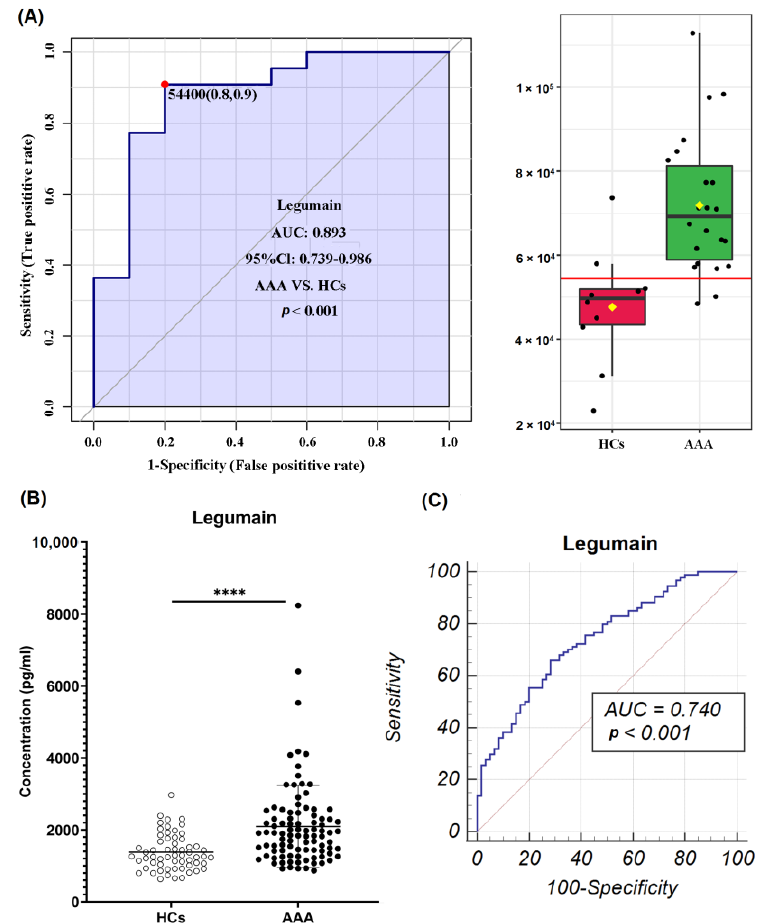
Figure 2. Diagnostic performance of LGMN in the discovery and validation cohorts. ( A ) ROC analysis of LGMN according to protein array data; ( B ) ELISA result of LGMN in validation cohort 2; ( C ) ROC analysis of LGMN in validation cohort 2. **** p < 0.0001